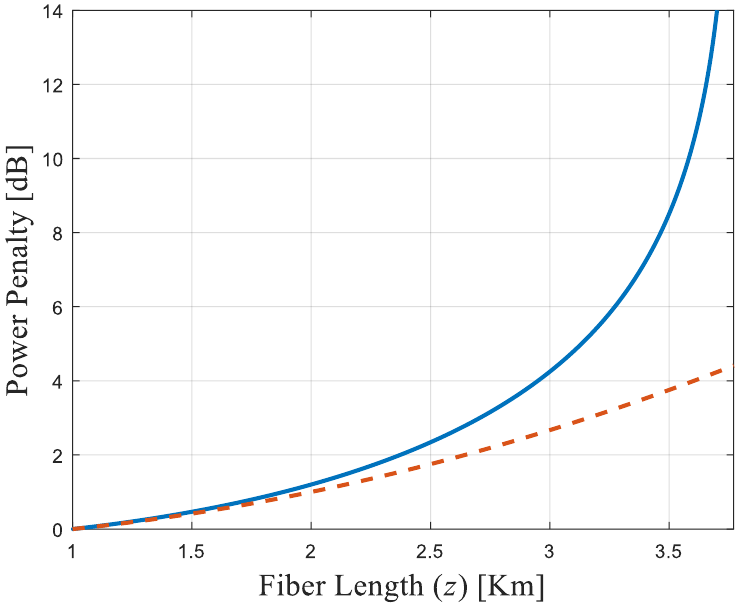
Figure 7. Power penalty as a function of the fiber’s length. The solid curve stands for Equation (34) and the dashed curve stands for the approximation of Equation (35). The data ( N = 4) was transmitted at a rate of B = 53 Gbaud in the C-band.